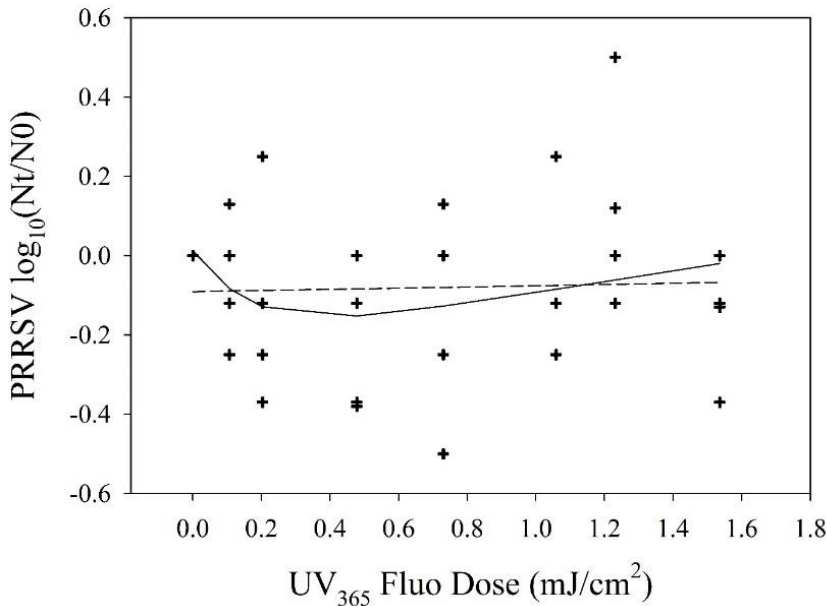
Figure A3. UV-A (365 nm, fluorescent) treatment inactivation curve on aerosolized PRRSV. One- stage (dashed line) and two-stage (solid line) inactivation curves were drawn. PRRSV survival is expressed as log 10 (N t /N 0 ), not as a percentage (%) as shown in Figure 4.